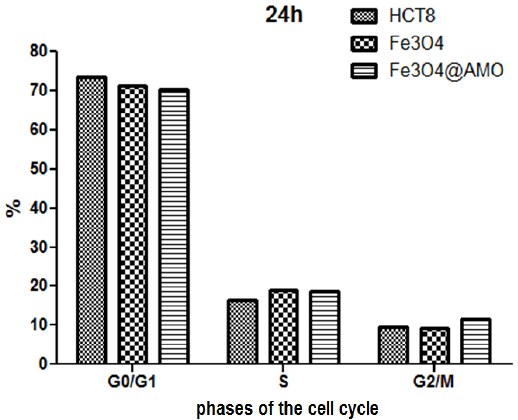
O ; 3 4 O @AMO. p < 0.5, 3 4